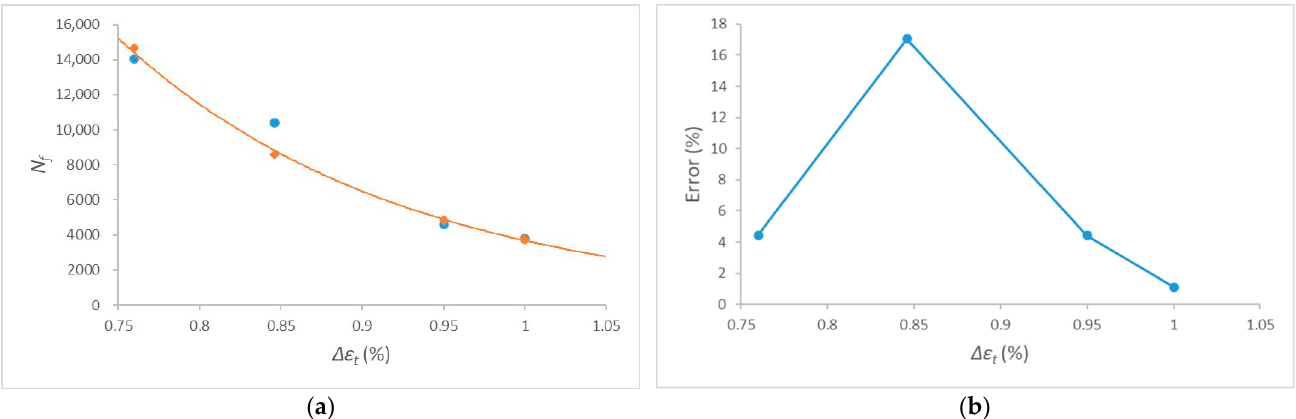
Figure 8. Life prediction of non-destructive specimens with R = 0.05: ( a ) Fatigue life prediction curve ( b ) Fatigue life prediction error.